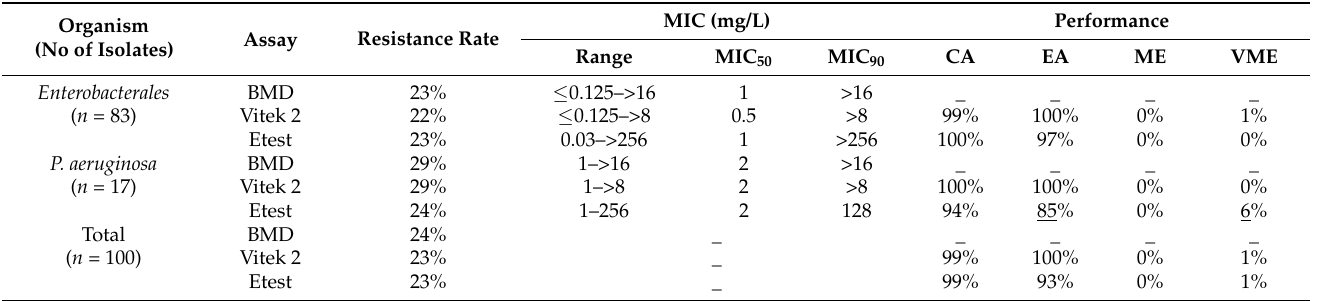
Table 2. Comparison of testing methods for the determination of susceptibility of Enterobacterales and P. aeruginosa isolates to ceftazidime/avibactam according to the current EUCAST breakpoints [21].